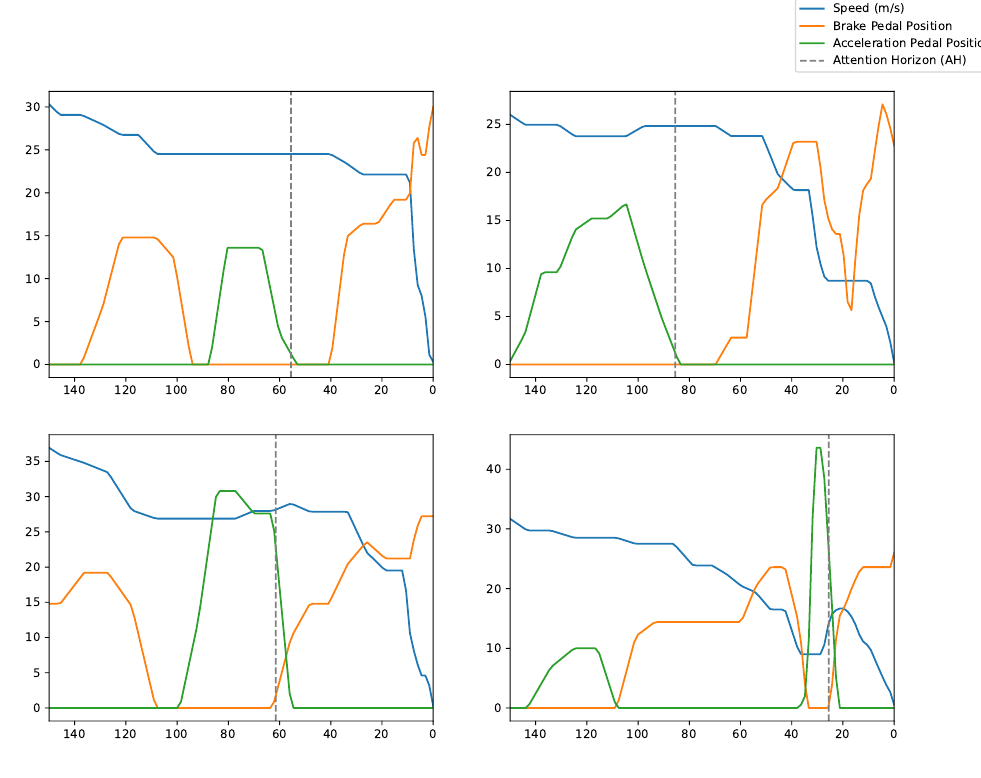
Figure 2. The sequence of acceleration and brake pedal positions, as well as vehicle speeds, just before stops at traffic lights. Four examples from the same traffic light are presented. The calculated AH is shown at the dashed vertical line. Brake and acceleration pedal positions have a possible value range from 0 (fully released) to 100 (fully pressed).